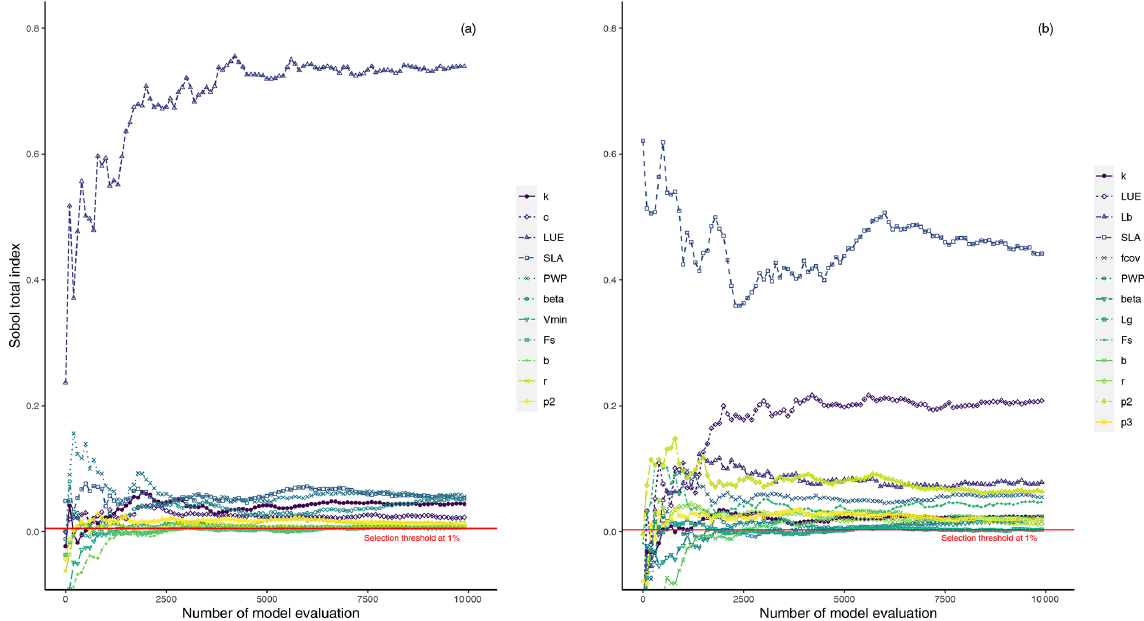
Figure 4. Illustration of the evolution of total-order Sobol’ indices (total-order indices convergence) for sensitive parameters with an in- creasing number of samples for GPP (a) and LAI (b) outputs at the DE-HoH site, taken as an example including soil moisture stress-related